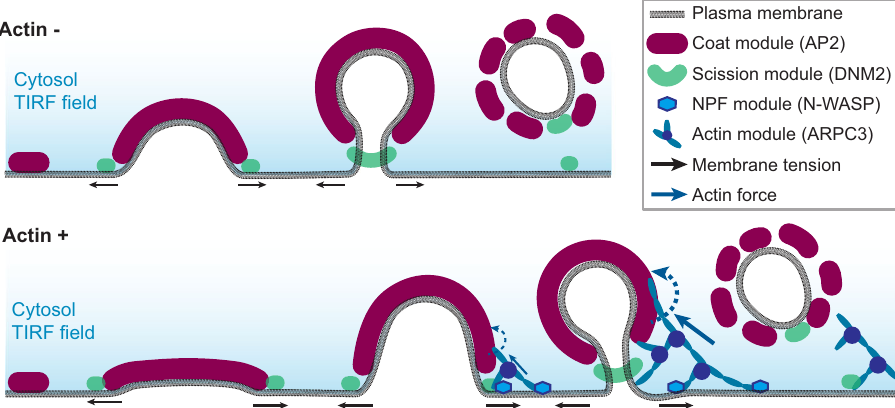
Fig. 7 An updated schematic model of actin-negative and actin-positive clathrin-coated pits in human cells. Actin assembly is induced at stalled CME sites, where asymmetric forces pull, bend and possibly twist the plasma membrane against membrane tension to drive membrane invagination and